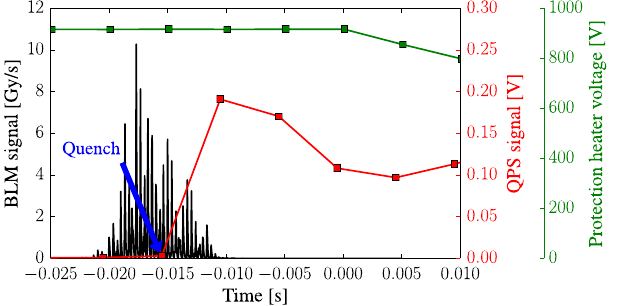
FIG. 13. Comparison of MAD-X simulation and data collected by a beam-position monitor during the intermediate-duration orbit-bump quench test.